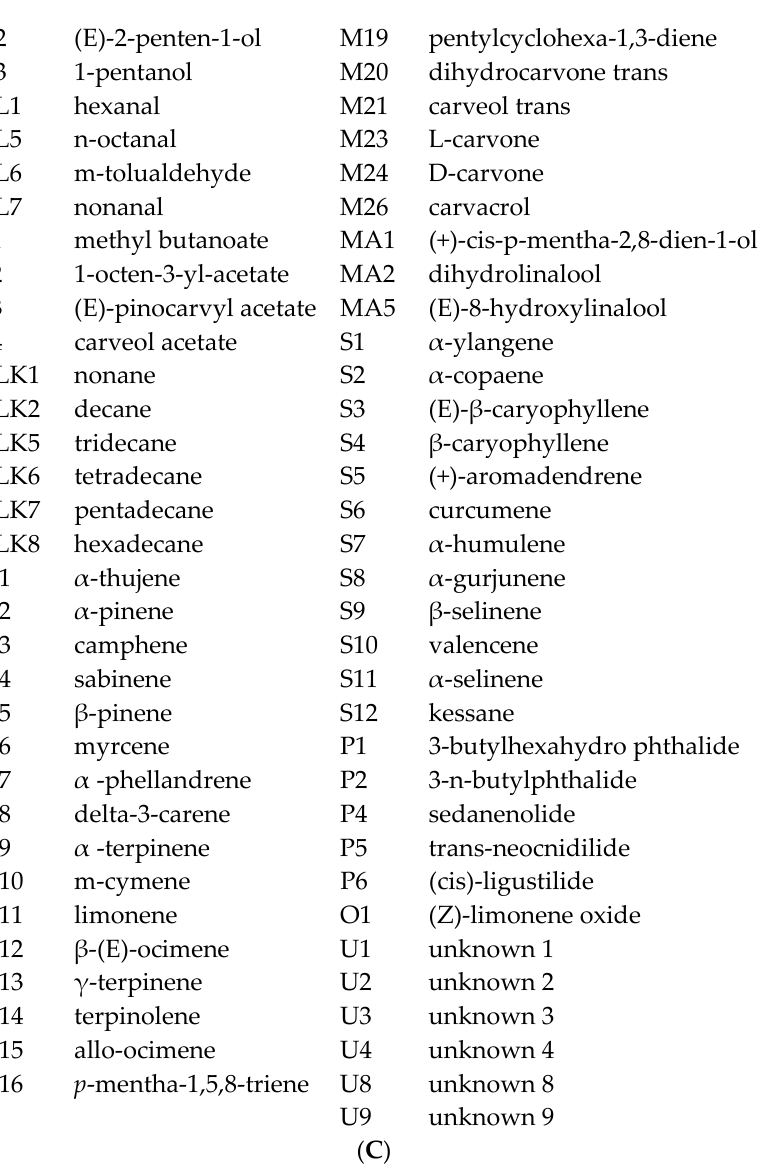
Figure 3. Principal component analysis of eight celery samples harvested in 2020 showing correlations with volatile compounds and sensory attributes. ( A ) Projection of the samples; ( B ) Distribution of the variables; ( C ) Compound codes as they appear in plot ( B ).